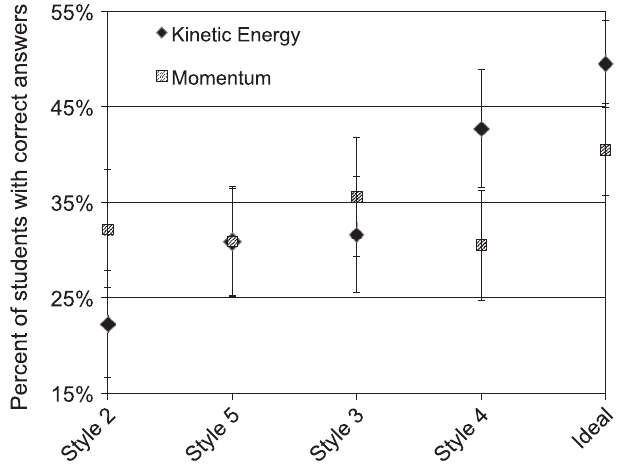
FIG. 3. Student post-test performance for recitation styles in- volving cooperative learning groups and verbal interactions with teaching assistants. Error bars indicate the standard error of the